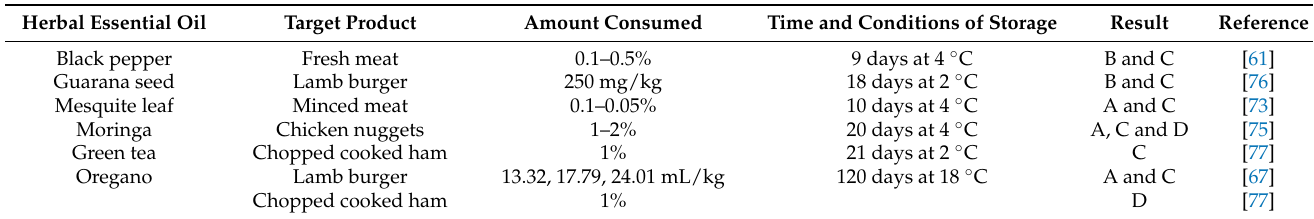
Table 3. List of uses of plant extracts as natural antioxidants in meat and meat products. Herbal Essential